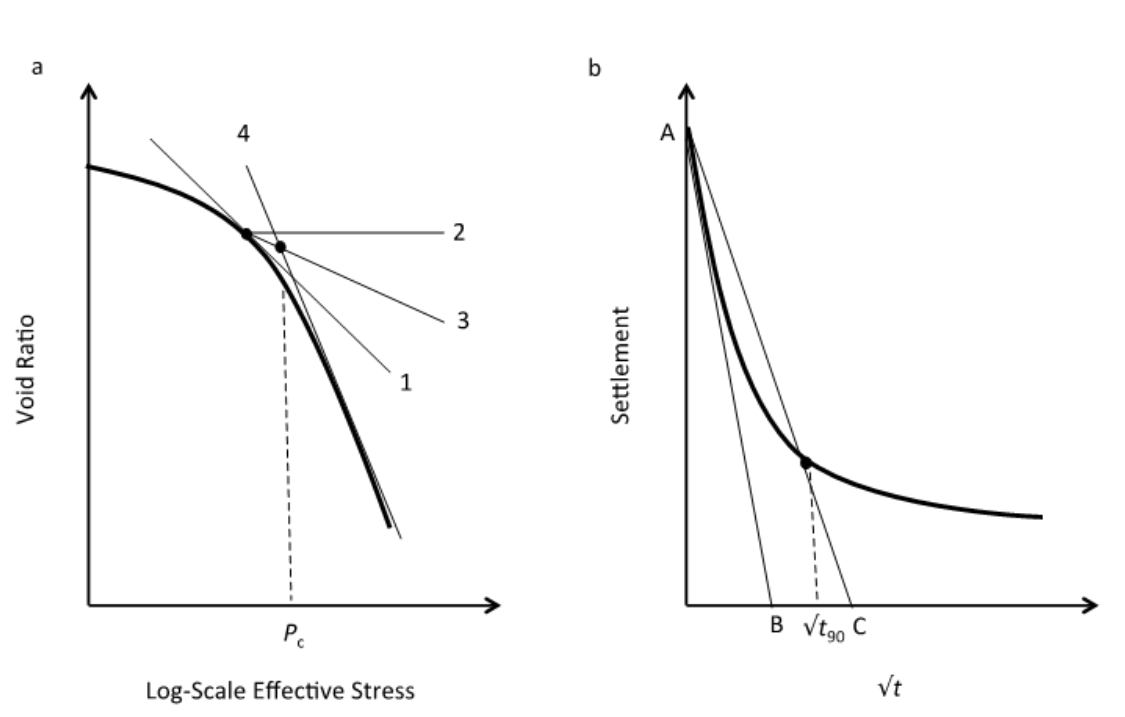
Figure 1. Graphical procedures for estimating (a) preconsolidation pressure following Casagrande (1936), and (b) time of 90 % consolidation following Taylor (1948). See text for